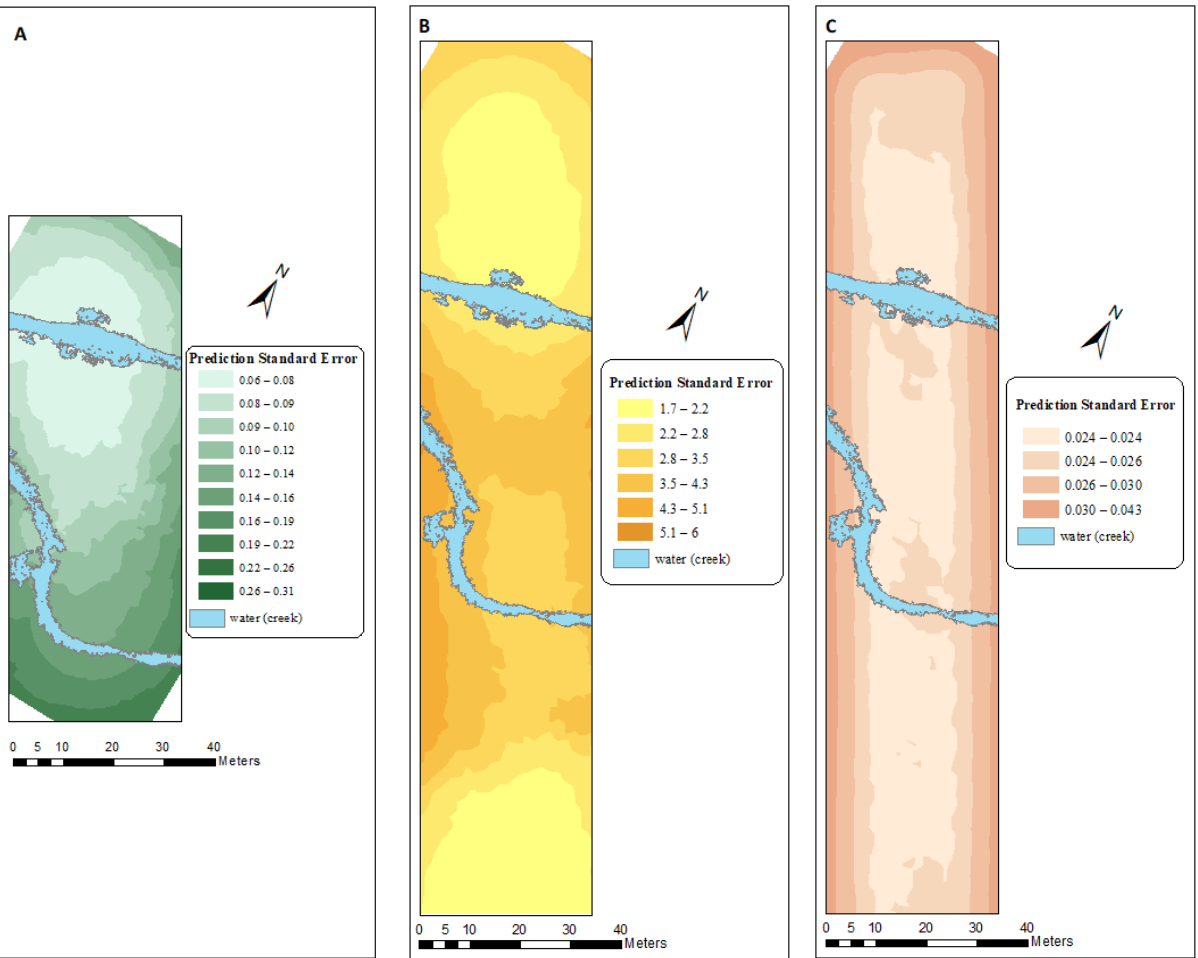
Figure A3. Contour map of Prediction Standard Error of (A) K s, log-transformed (m s -1 ), (B) SOM (%w/w), (C) SSM (in metres above mean sea